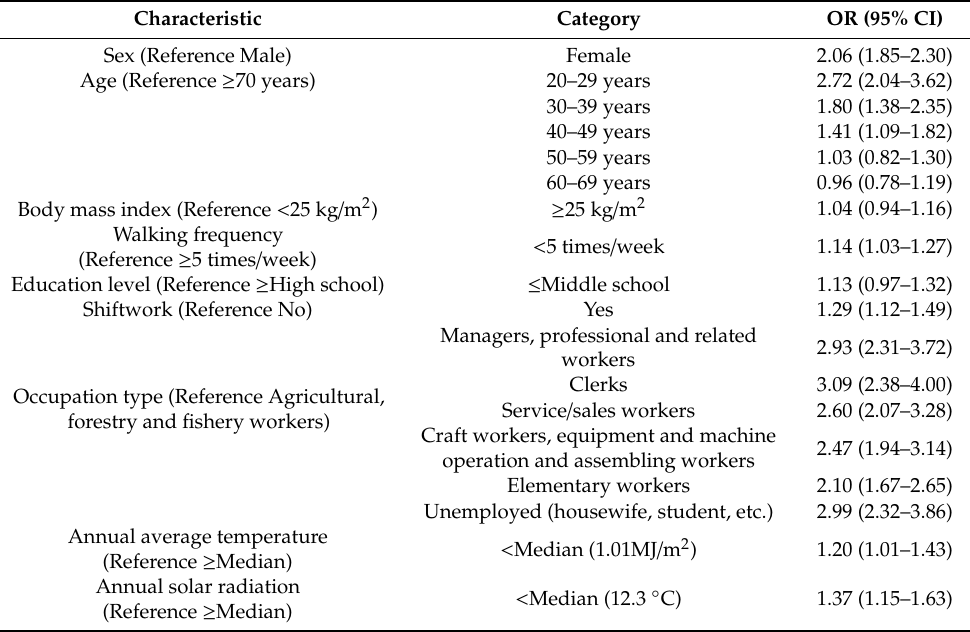
Table 2. Logistic regression analysis of association between occupational and environmental factors and vitamin D deficiency ( < 20 ng / mL) from KNHANES